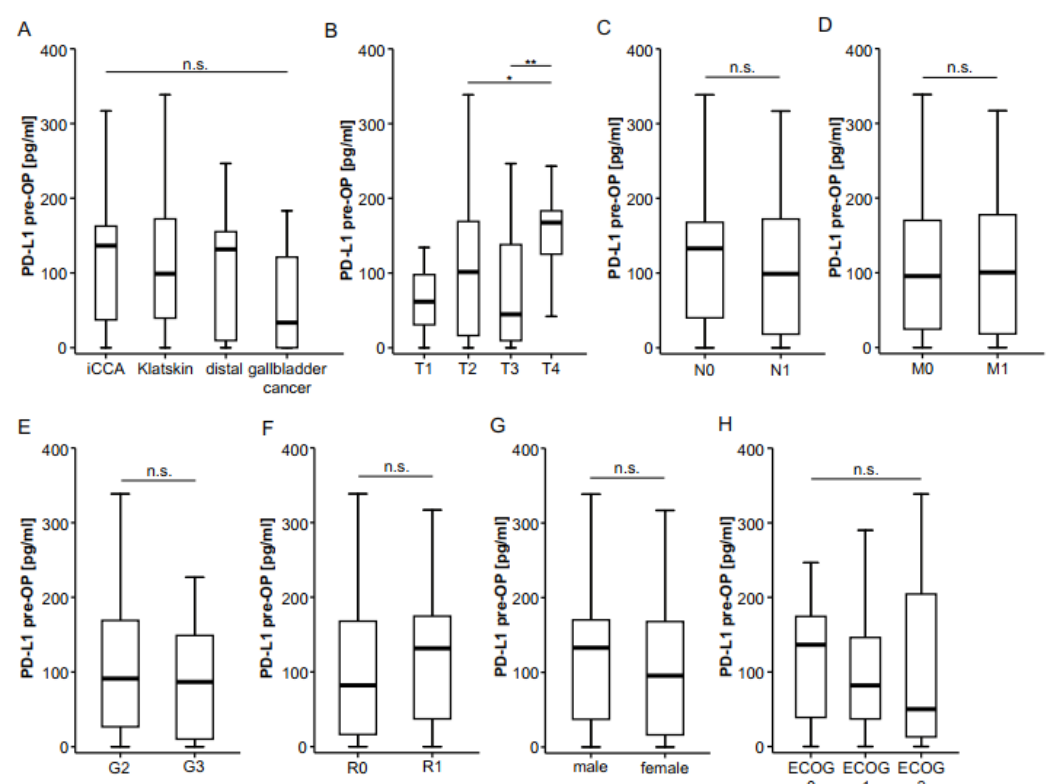
Figure 2. Preoperative serum PD-L1 does not correlate with clinicopathological characteristics. ( A ) Initial serum PD-L1 levels do not differ between different BTC localizations. ( B ) Concentrations of circulating PD-L1 are significantly higher in T4 tumors but unaltered between N0/N1 ( C ) and M0/M1 ( D ) stages. Concentrations of circulating PD-L1 are unaltered between moderately and poorly differentiated tumors ( E ), complete (R0) and incomplete tumor resection (R1, F), male and female patients ( G ) or patients with different ECOG performance status ( H ). n.s. not significant; * p < 0.05; ** p < 0.01. Table 1. Correlation analyses between preoperative PD-L1 and routine laboratory